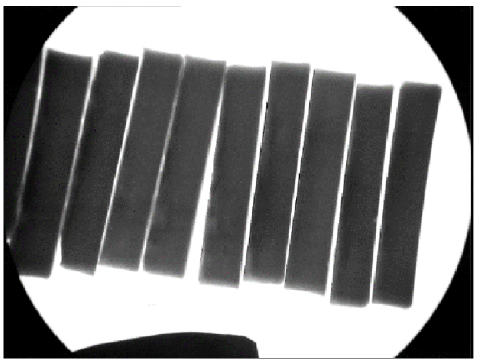
Figure 2. X-ray image showing no significant presence of porosity.